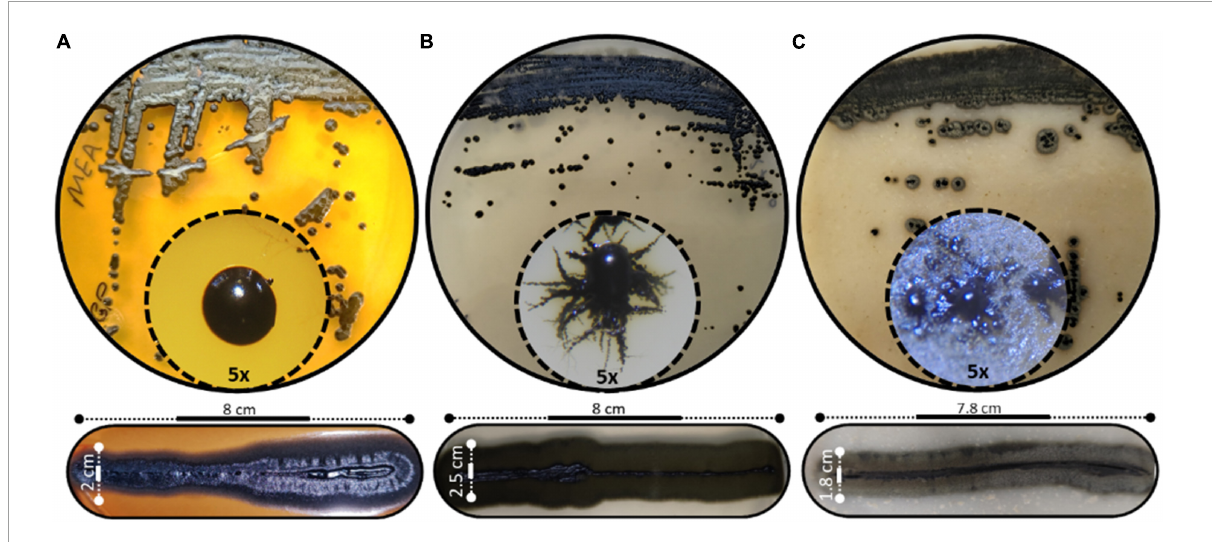
FIGURE2 Different scopes of Hortaea werneckii isolate GPS5. The progressive morphological growth as a colony with a closer 5 x zoom using a stereomicroscope is shown (above), and the line strike over three tested culture media (below). (A) MEA, (B) PDA, and (C) OMA.